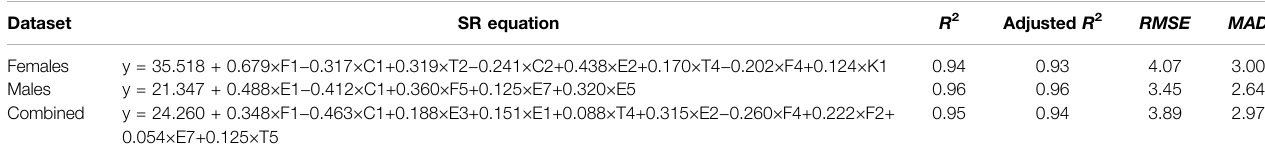
TABLE 1 | Stepwise regression (SR) equations and system ef fi ciencies in three different datasets of the CHS cohort ( n (cid:1) 240, blood samples).